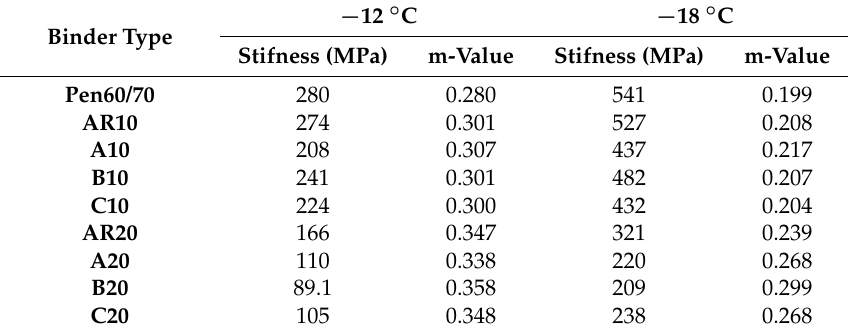
Table 6. BBR test